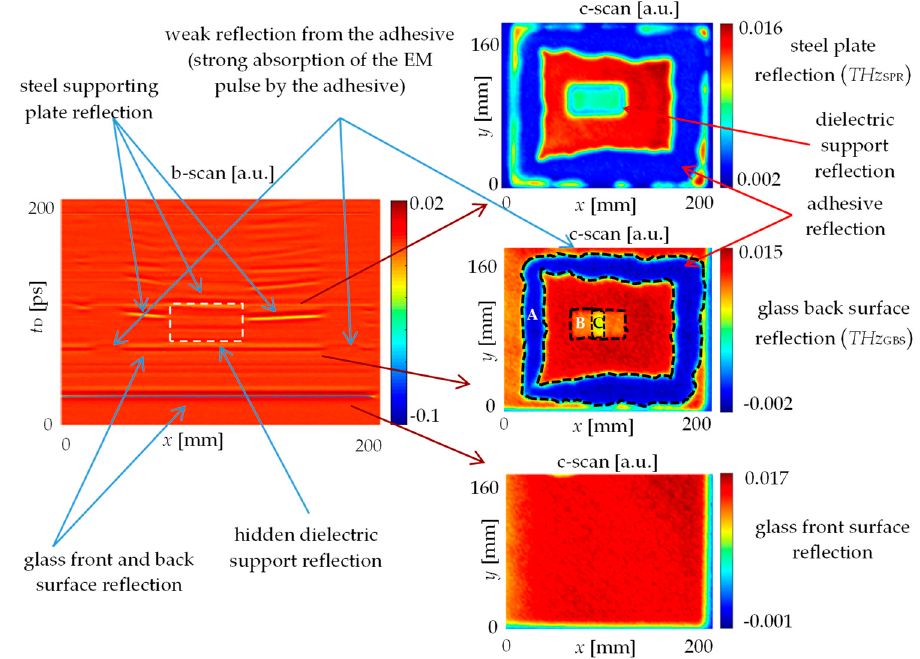
Figure 10. Signals obtained during pulsed terahertz inspection: b-scan ( left side) and c-scans measured in case of various depths ( right side); (A)—adhesive path, (B)—dielectric support, (C)—glass–support adhesive connection.